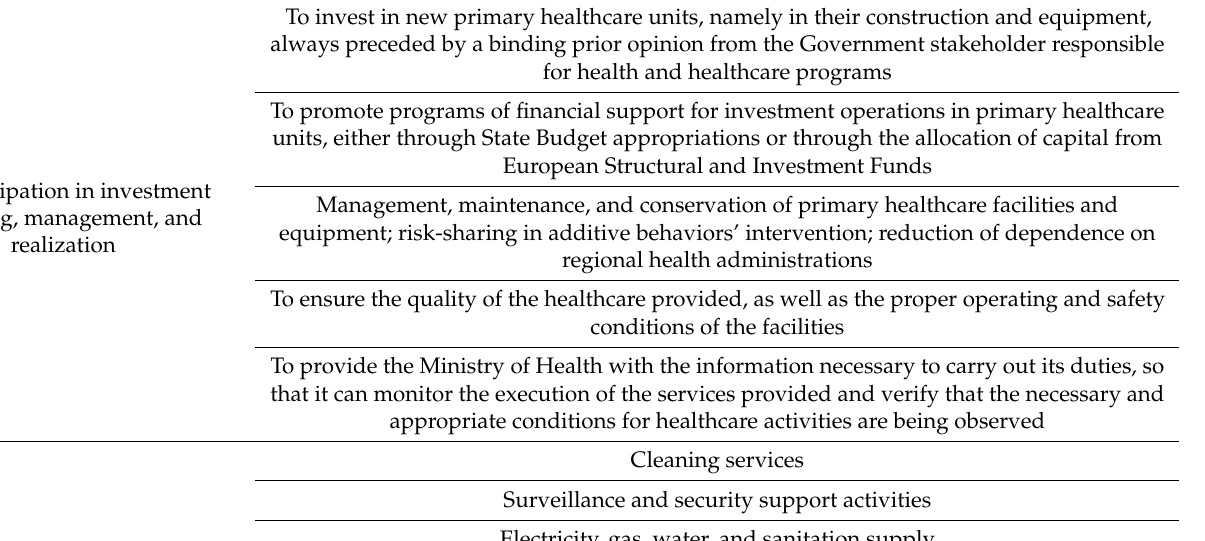
Table 3. Competencies assigned to municipalities in the health decentralization process for primary healthcare